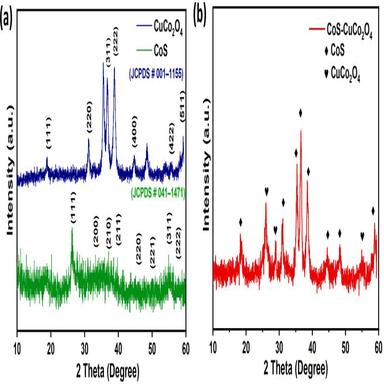
(a) XRD pattern of CoS, CuCo2O4 and (b) CoS-CuCo2O4 composite.